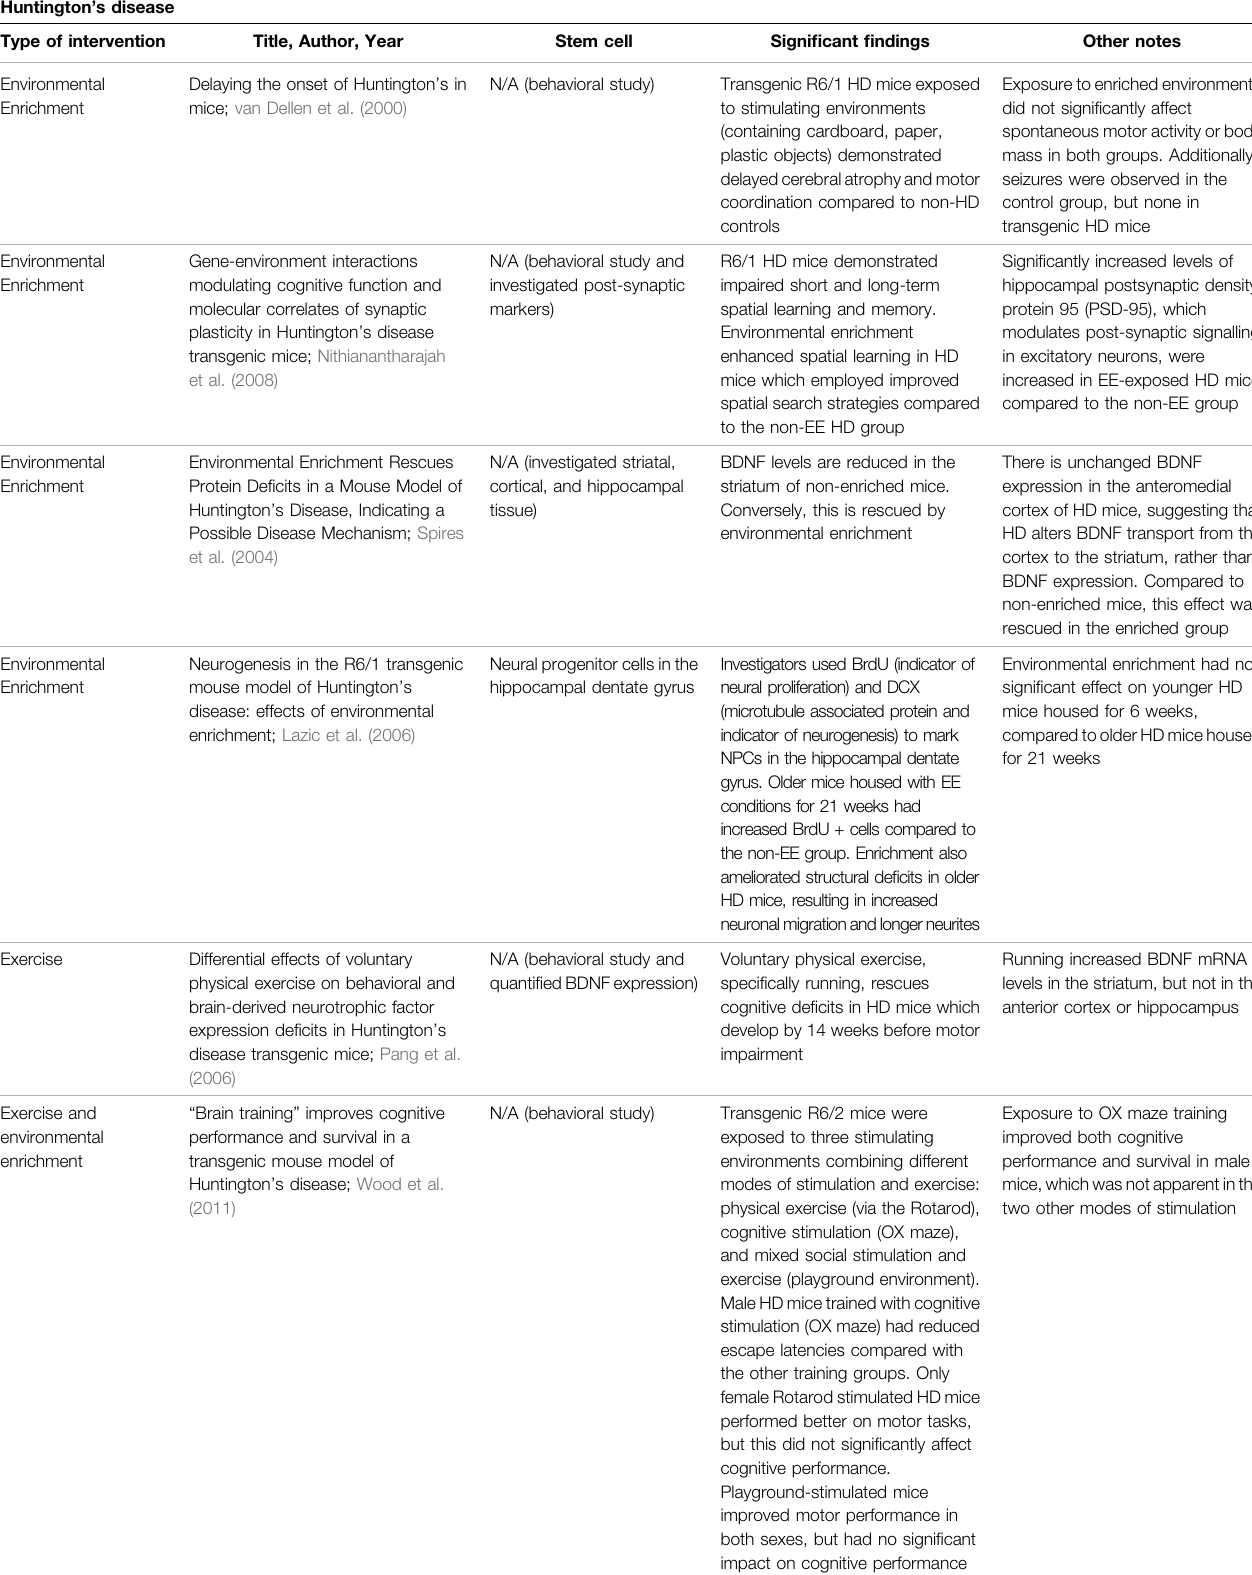
TABLE 5 | Experimental studies for Huntington ’ s disease with stem cell transplantation, an enriched environment, exercise, and a combination of enriched environment or exercise with stem cells. Huntington ’ s